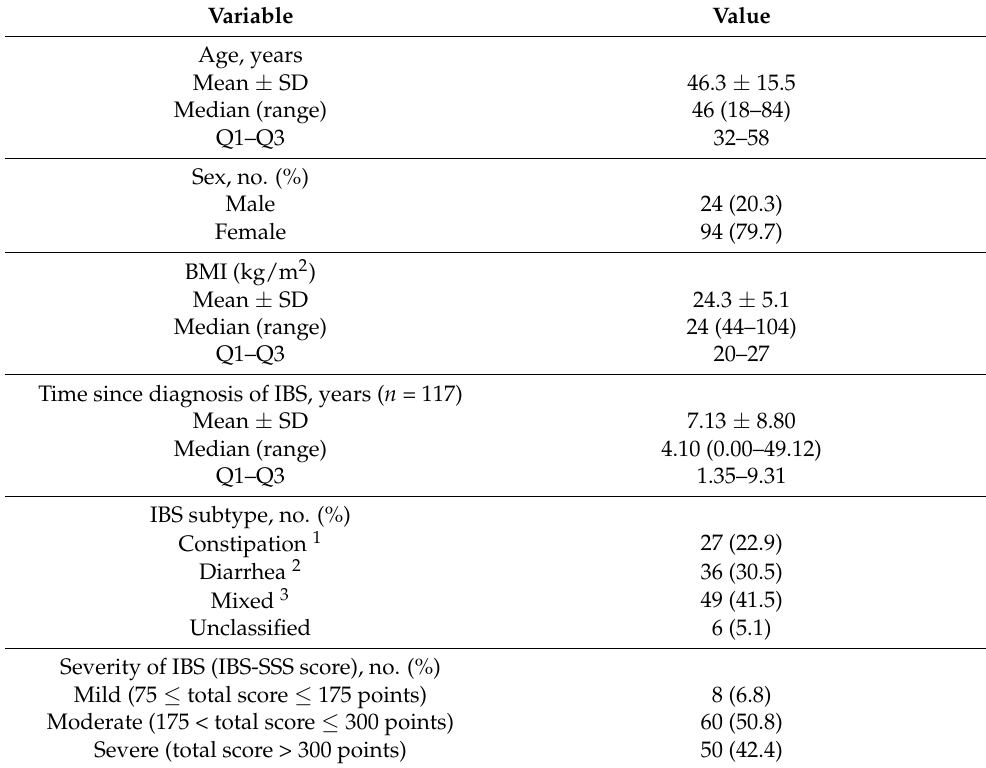
Figure 2. Flow chart of patient populations. ITT, intention to treat; PP, per protocol; V, visit; IBS-SSS, Irritable Bowel Syndrome Symptom Severity Scale. Table 1. Baseline patient characteristics (ITT population, n = 118).